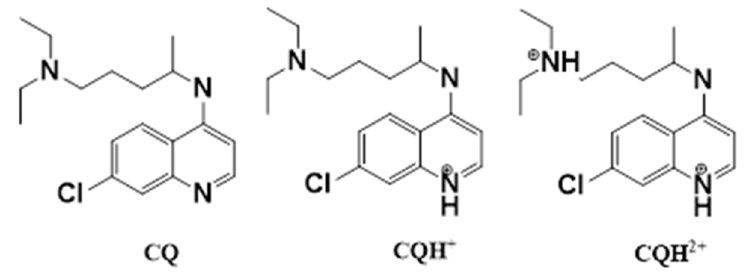
Figure 1. Different ionic forms of CQ studied in this work.